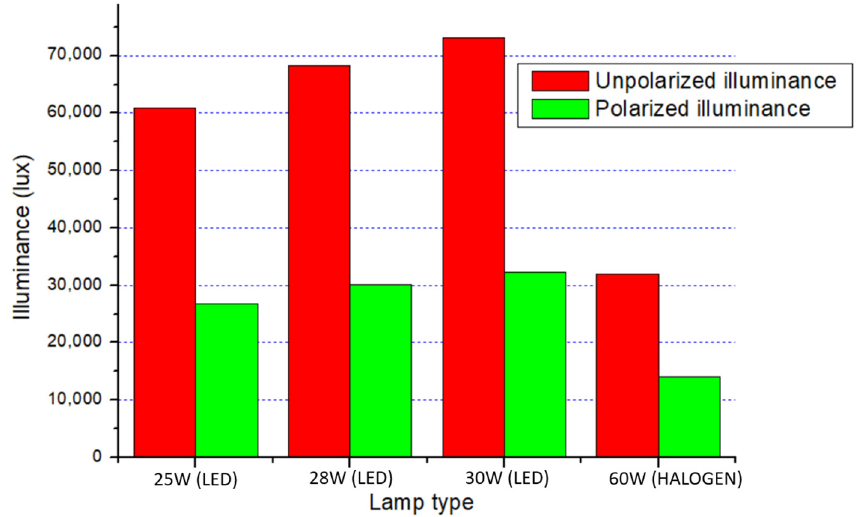
Figure 4. Illuminance measurements of LED (25 W, 28 W, and 30 W) and halogen headlights (60 W).